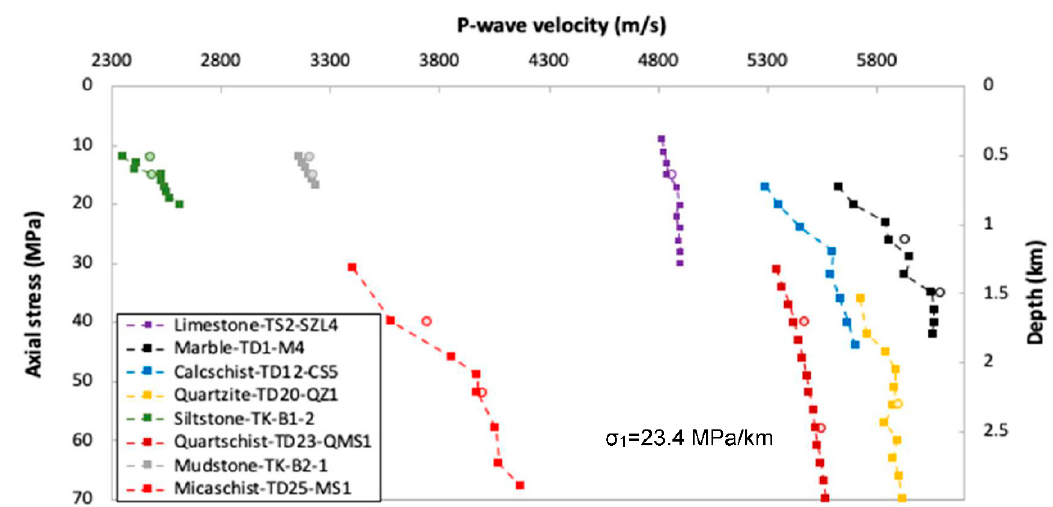
Figure 8. P-wave velocity as a function of axial stress, and thus depth below the surface, for all eight CCS tests conducted within experimental series D. After the samples were loaded until their maximum σ 1 (Table 5), unloading took place during which several acoustic measurements were taken to check for potential hysteresis effects (circular data points). σ 2 was kept constant and is presented in Table 5. Axial stress–depth relationship is taken from [35].